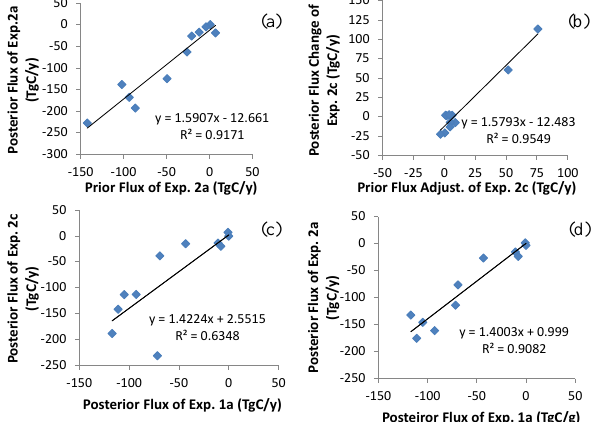
Figure 5. Dependence of the posterior flux from inversions on the prior flux for regions 18–28. (a) Correlation between posterior fluxes from experiment 2a and their prior fluxes, (b) correlation be- tween changes in posterior fluxes from experiment 2c and adjust- ments to their prior fluxes, (c) correlation of the posterior fluxes between experiment 1a and experiment 2c, and (d) correlation of the posterior fluxes between experiment 1a and experiment